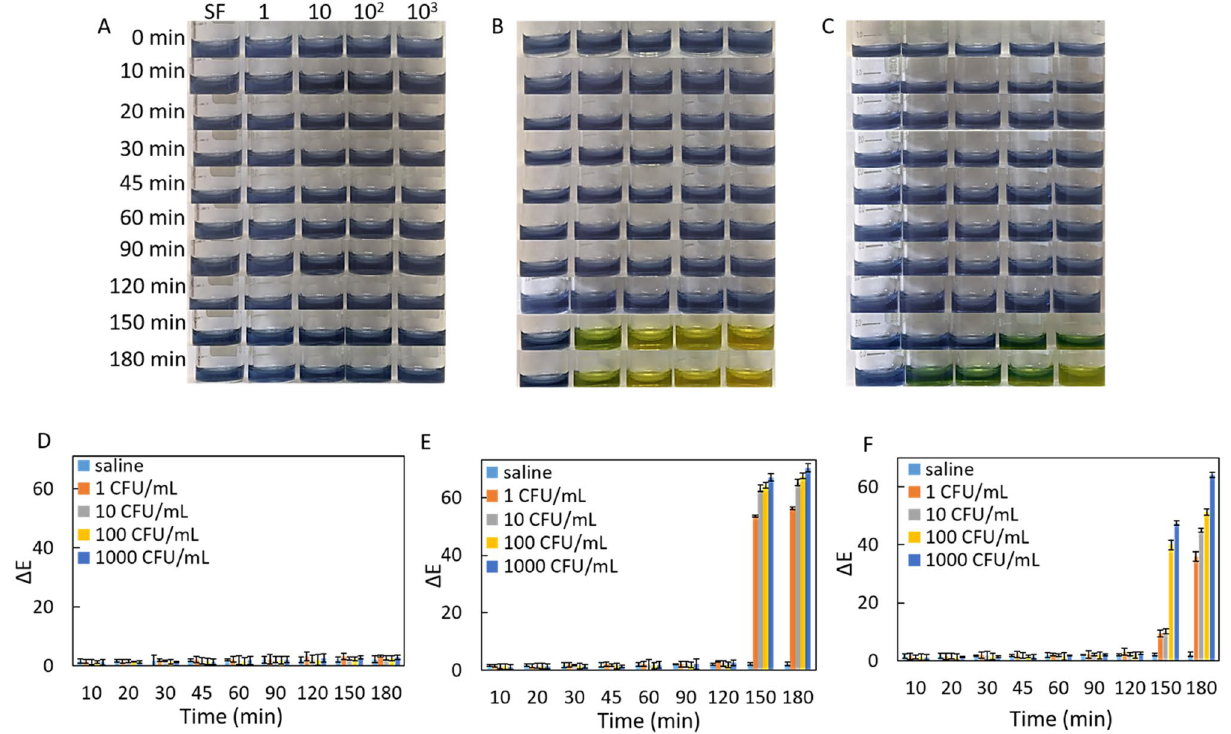
Figure 2. Colorimetric readouts of test 2 with a naked eye for ( A ) E. coli, ( B ) K. pneumoniae and ( C ) P. mirabilis . With ΔE values for ( D ) E. coli, ( E ) K. pneumoniae and ( F ) P. mirabilis . The error bars demonstrate one standard deviation (SD) obtained from three independent measurements (n = 3).